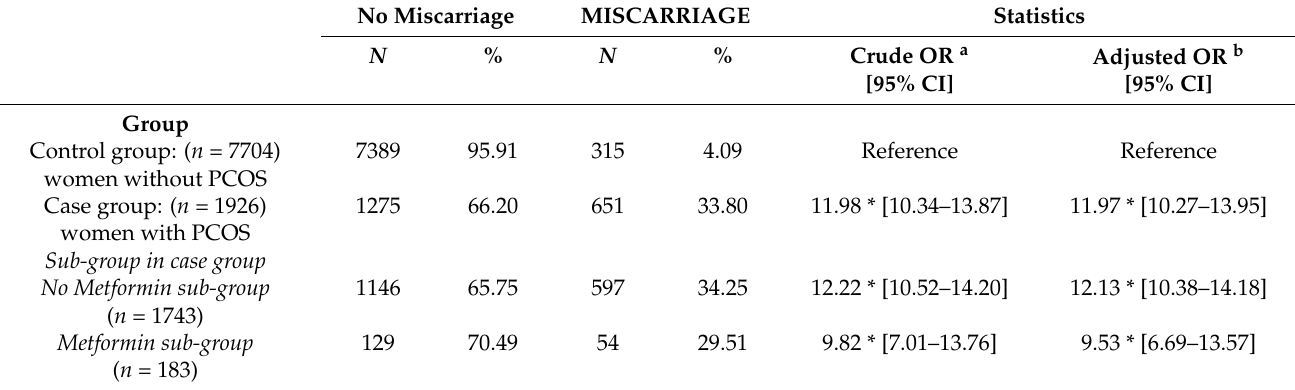
Table 2. The risk analysis of subsequent miscarriage for pregnant women with prior